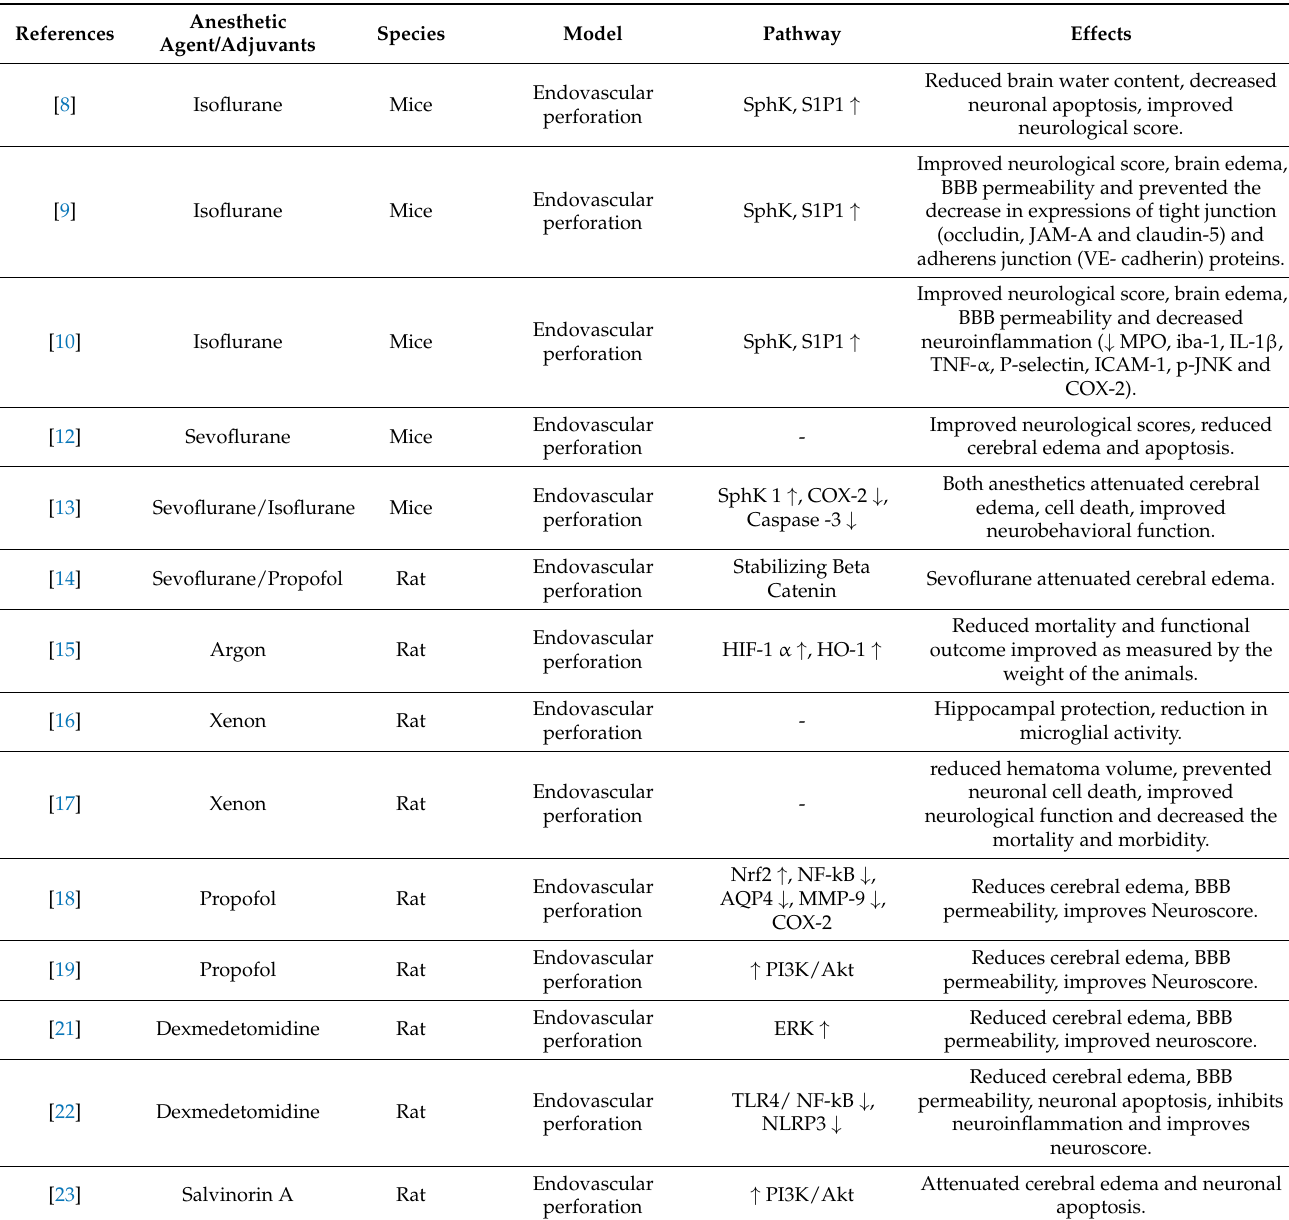
Table 1. Anesthetics and adjuvants in early brain injury (EBI) after SAH in experimental